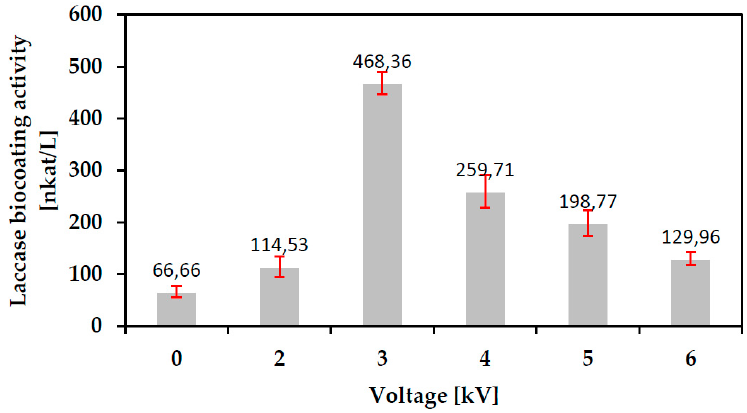
Figure 6. Laccase biocoating activity vs. Plasma generation applied voltage for as-deposited coatings on glass slides (V He = 10 L/min). on glass slides (V He = 10